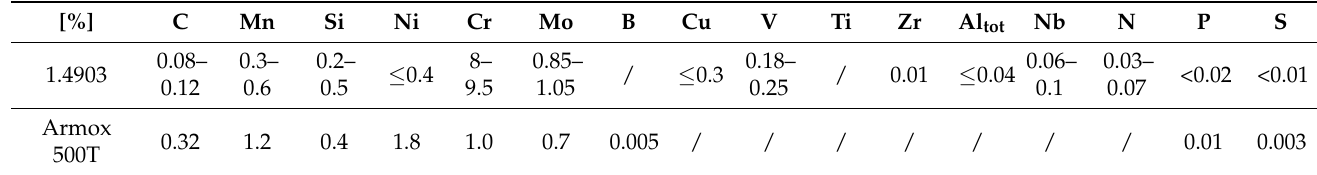
Table 1. Chemical compositions of base metals.